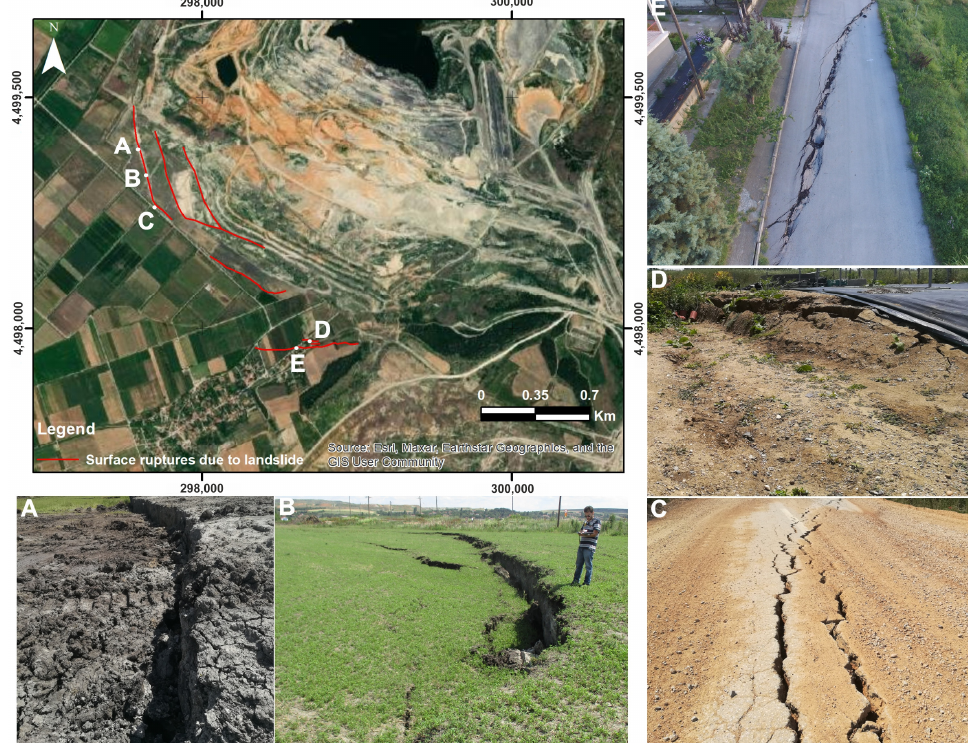
Figure 6. Spatial distribution of surface ruptures identified behind the crown of the 10 June 2017 landslide. ( A , B ) surface ruptures within the basin between Anargiroi and Valtonera village (the height of the scarp is approximately 1 m), ( C , D ) pre-existing surface ruptures caused by the land subsidence phenomenon that were intensified by the landslide event in the NW part of Anargiroi village, and ( E ) damage along the Anargyroi village road network.